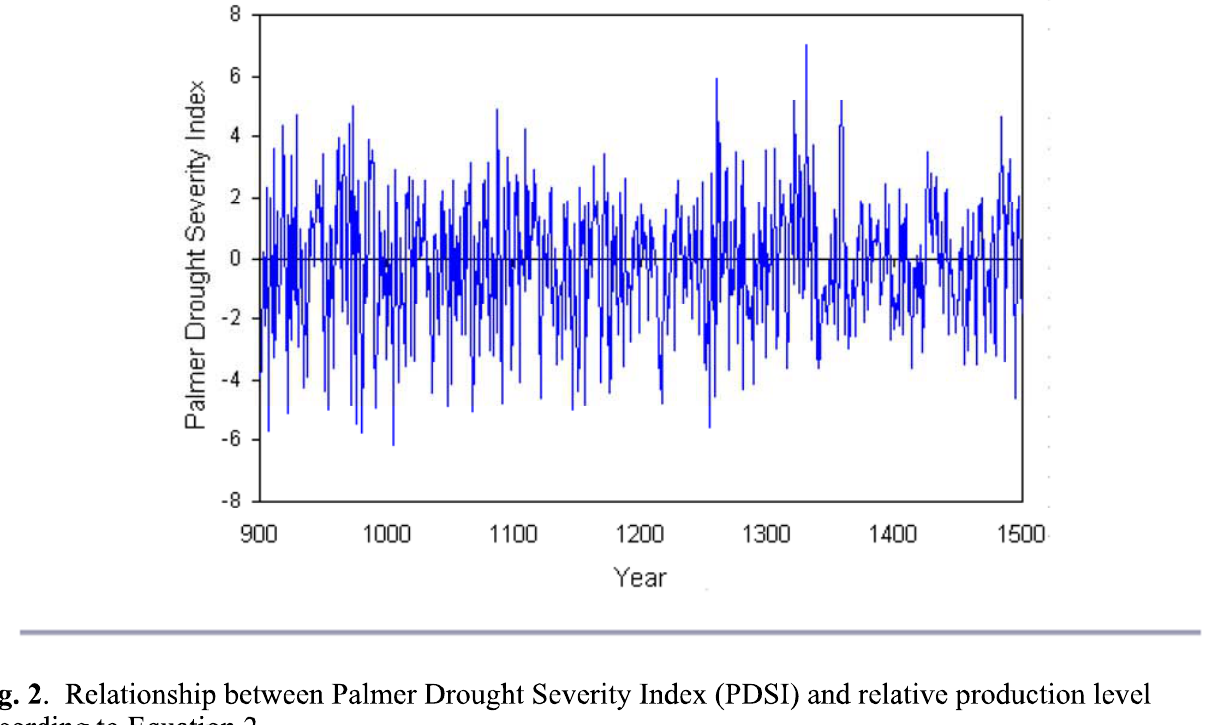
Fig. 1. The time series of Palmer Drought Severity Index that is used as input for the